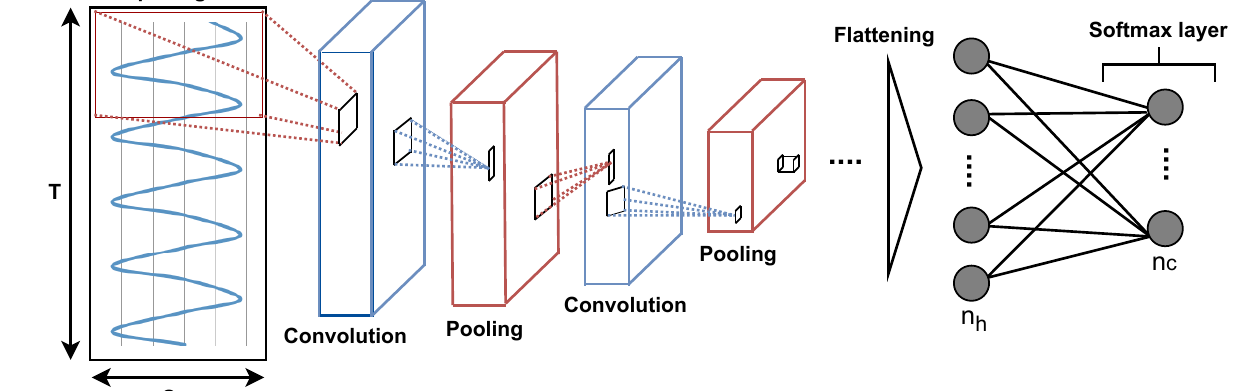
Figure 4. Illustration of a Convolutional Neural Network (CNN) model with convolutional layers, pooling layers, h dense layers, and c output classes represented by a softmax layer. Input data are processed by convolutional layers and pooling layers, and are passed to dense layers after extraction of profound